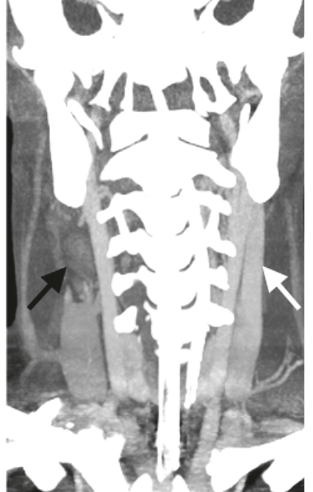
Figure 4: Coronal maximum intensity projection from CT scan of the neck with intravenous contrast. There is complete occlusion of the rightinternaljugular vein (black arrow). The left internaljugular vein is patent (white